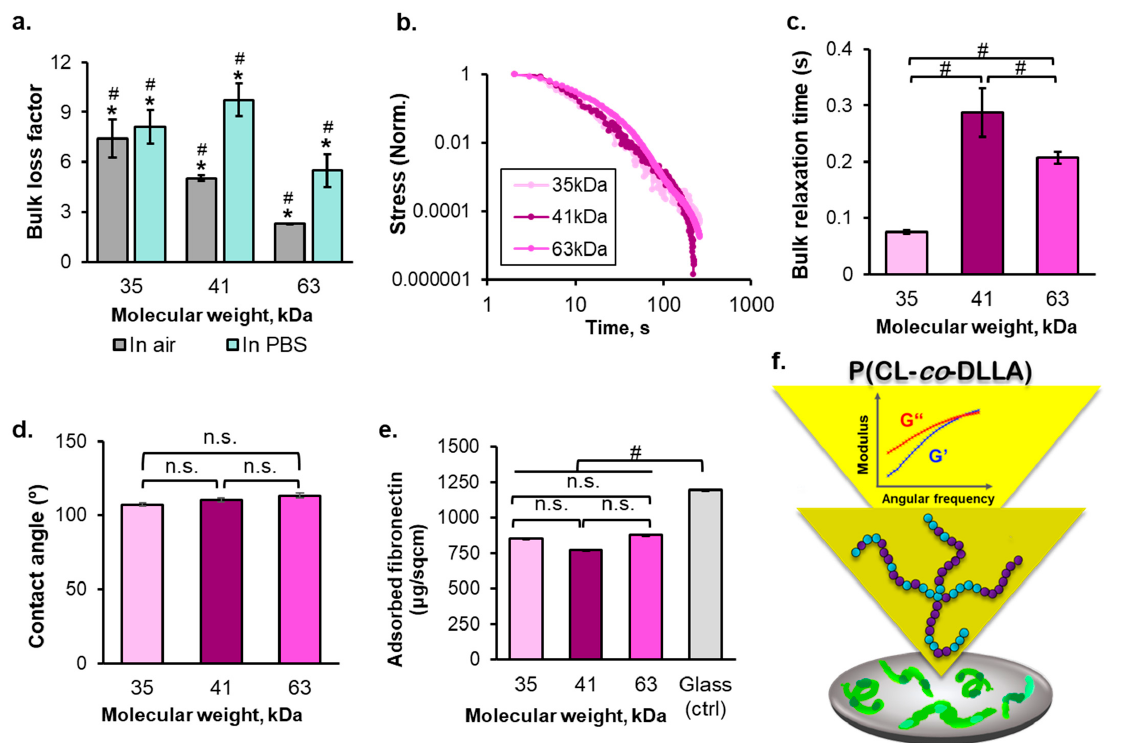
Figure 1. ( a ) Bulk loss factor of the copolymer substrates obtained by rheometer at 1 Hz angular frequency and 37 °C, ( b ) bulk stress relaxation of the copolymer substrates obtained by rheometer at 10% strain concentration (normalized to their each maximum individual stress), ( c ) bulk relaxation time of the copolymer substrate obtained by fitting the stress relaxation curve to the standard linear solid model, ( d ) the contact angle of the copolymer substrates, ( e ) the quantified amount of adsorbed fibronectin on each substrate, and ( f ) the schematic illustration of the fibronectin (green)-coated copolymer substrate used as a cell culture substrate. (Statistical analyses: Student’s t -test n.s. p > 0.05; # is the comparison between samples p < 0.05; * is the comparison between different treatment p <